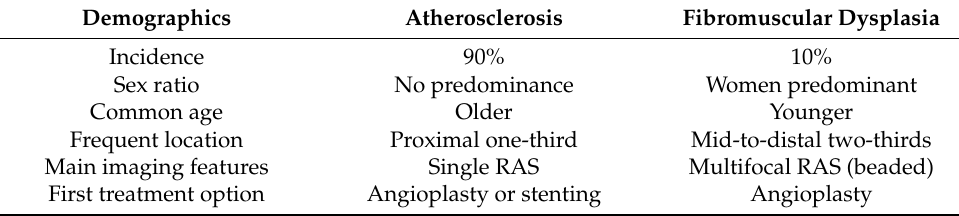
Table 1. Main etiologies of RAS: differences regarding demographics and treatment. Demographics Atherosclerosis Fibromuscular Dysplasia Incidence 90% 10% Sex ratio No predominance Women predominant Common age Older Younger Frequent location Proximal one-third Mid-to-distal two-thirds Main imaging features Single RAS Multifocal RAS (beaded) First treatment option Angioplasty or stenting